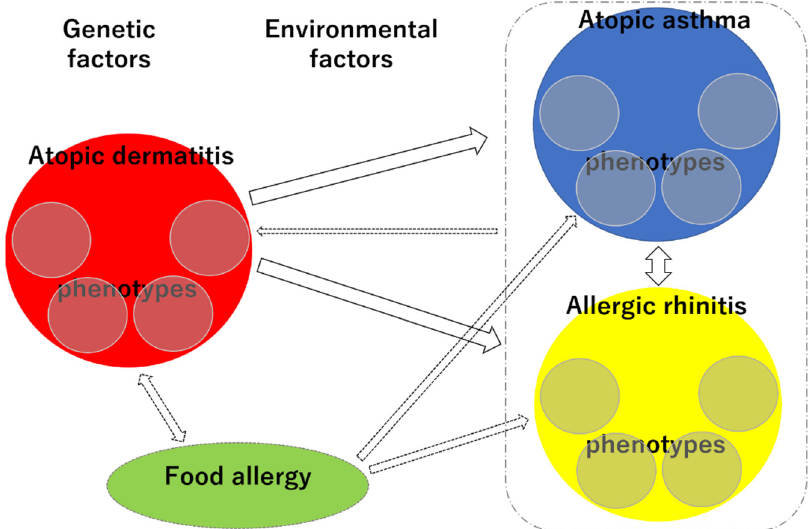
Figure 6. Schematic representation of the complex phenotypes and trajectories of each allergic disease. Small circles within red circle, each phenotype of AD; small circles within blue circle, each phenotype of AA; small circles within yellow circle, each phenotype of AR.